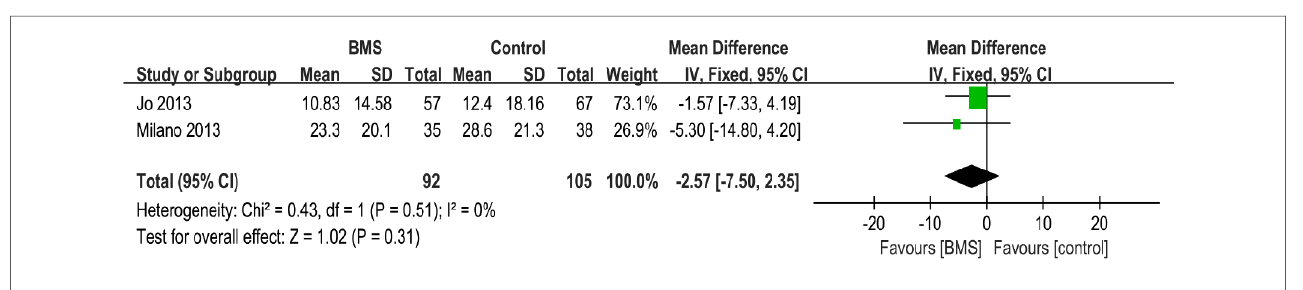
physiological subchondral trabecular distance are suf fi cient to stimulate bone marrow release while preventing anchor failure (62). By microstructural analysis of the humeral tuberosity in